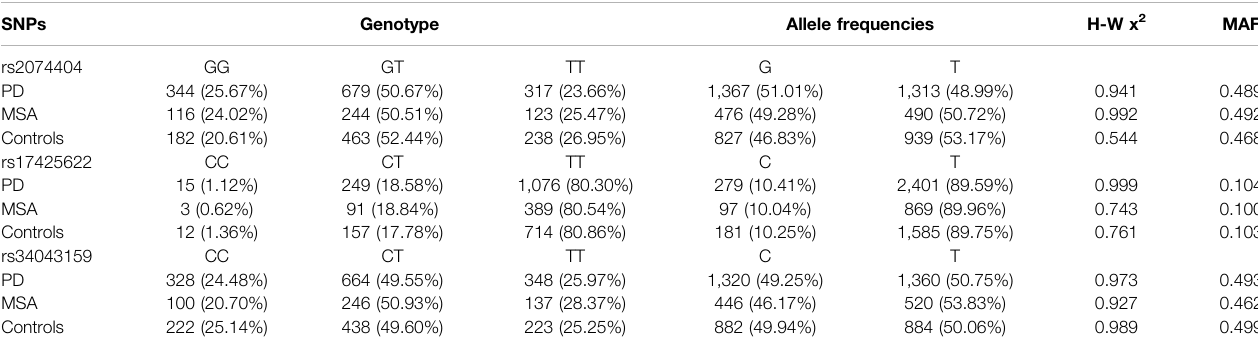
TABLE 2 | Distribution of genotype and allele frequencies of rs2074404, rs17425622 and rs34043159 in PD, MSA patients and controls.